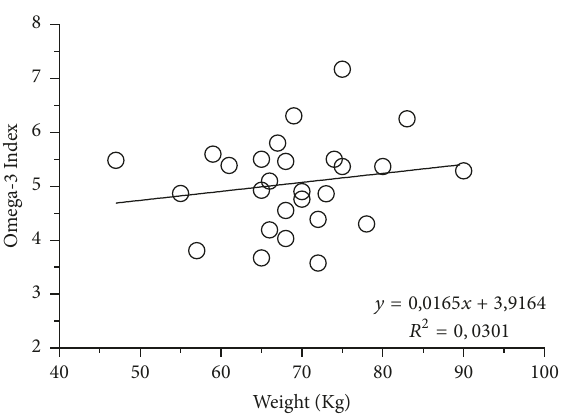
Figure 4: Delta change of the Omega-3 Index related to body weight and dosage: ( I ) group 2G, two oil gums daily; ( e ) group 3G, three oil gums daily. The changes on values of the O3Ix are more related to dosage than the previous body